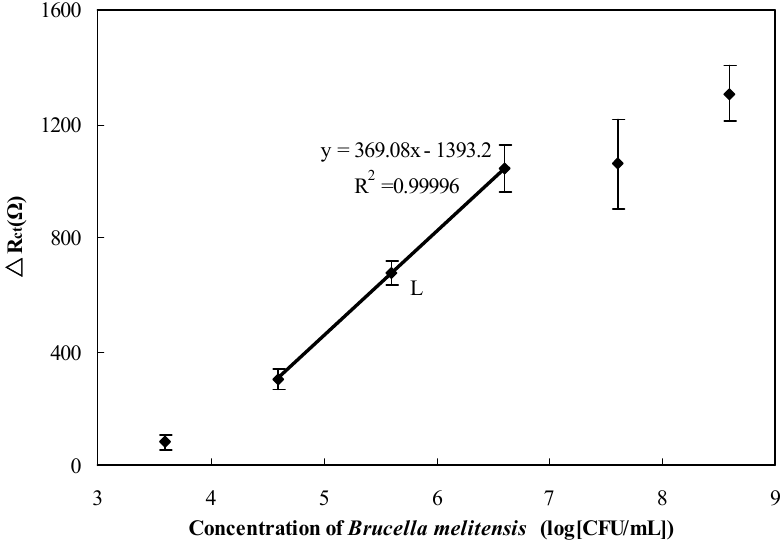
was derived from three independent measurements.